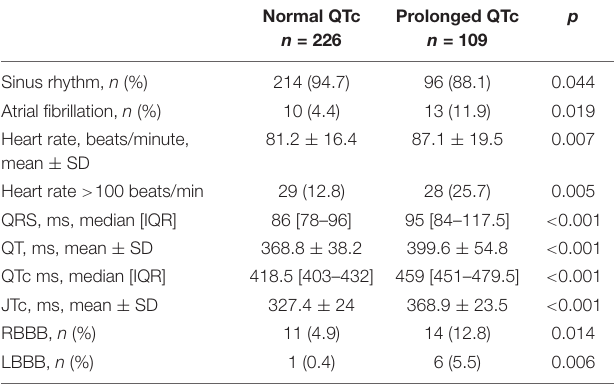
TABLE 2 | ECG characteristics.